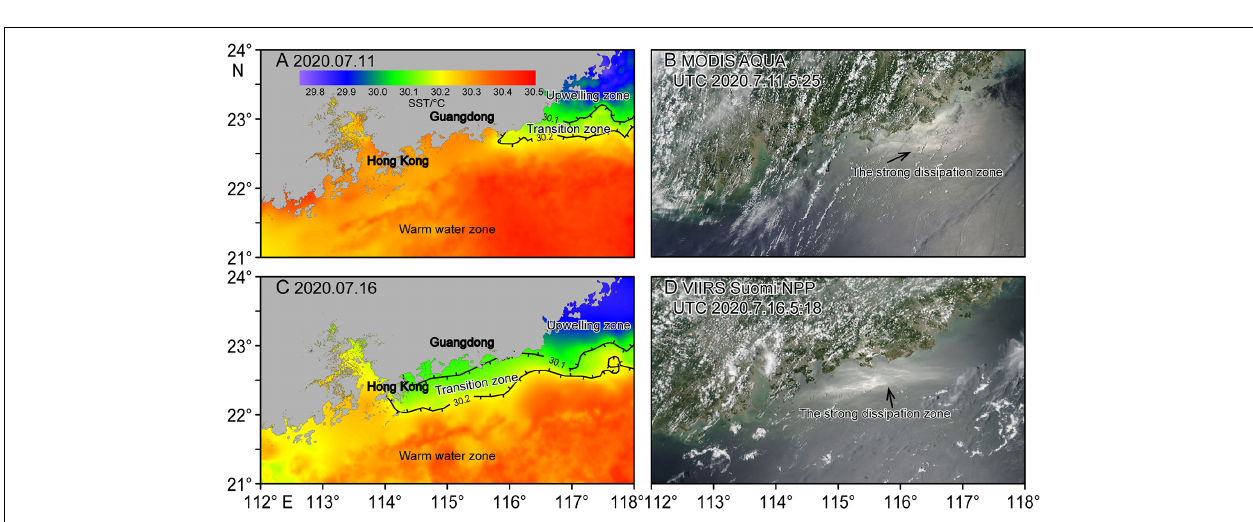
Frontiers in Marine Science |